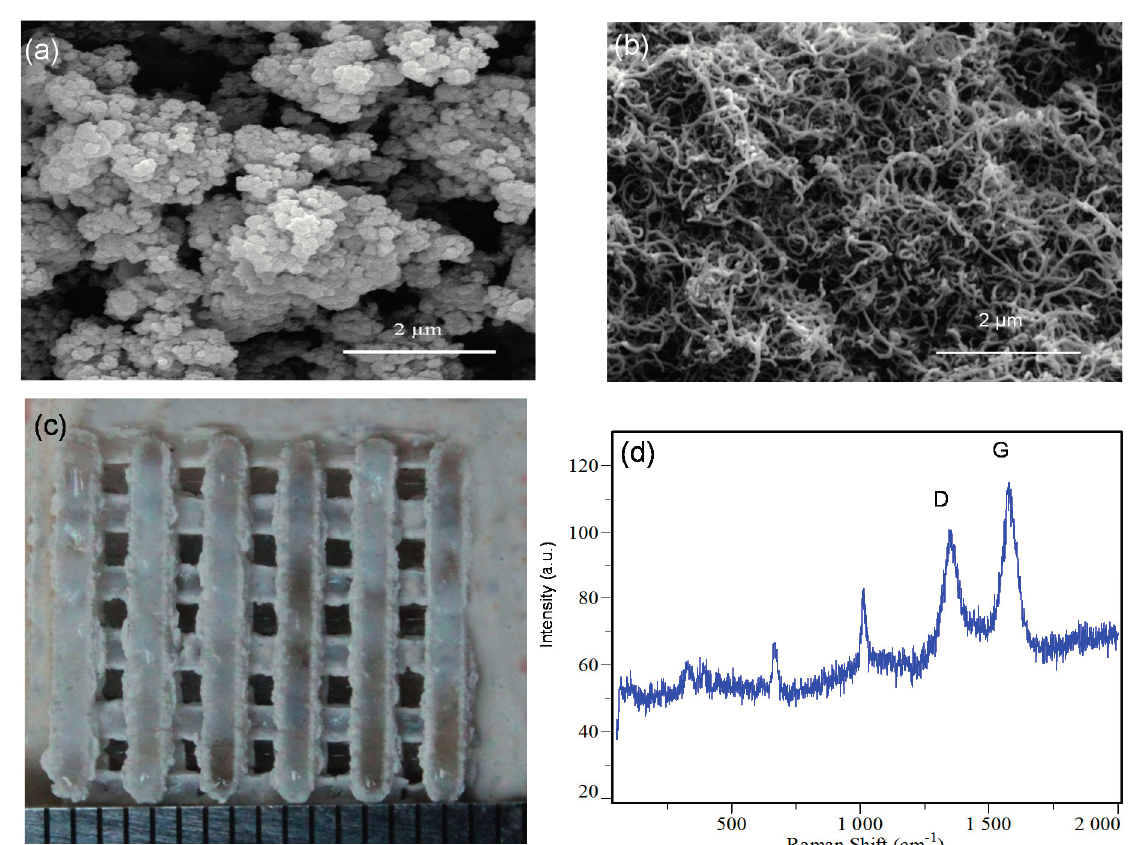
Figure 1. Morphology of the raw powders ( a ) Di powders; and ( b ) MWCNTs powders; ( c ) Di scaffold prepared by SLS; ( d ) Raman spectrum of the prepared scaffold, D: D band of CNTs; G: G band of